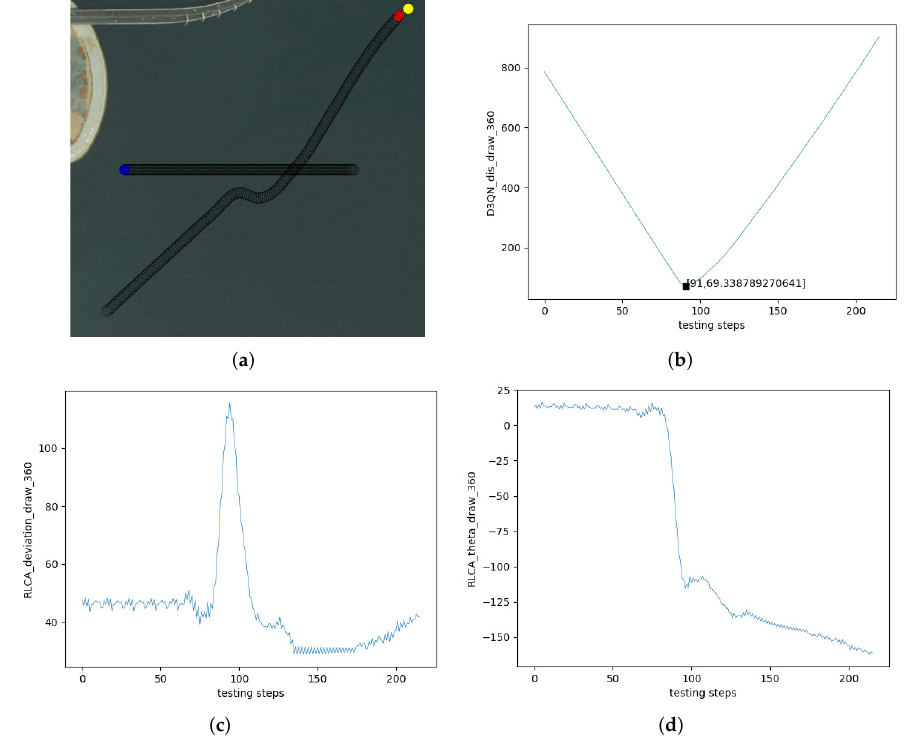
Figure 18. Test effect of Cross Encounter 1. ( a ) Crossing. ( b ) The distance between two USVs. ( c ) The course of the own USV. ( d ) θ of the own